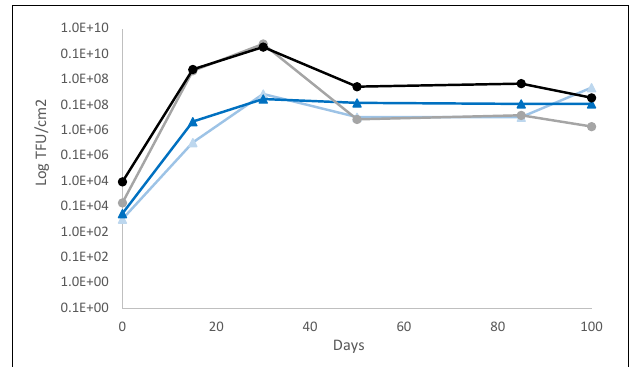
FIGURE 4 | Evolution of P. nalgiovense and P. nordicum populations during pilot-scale fermented sausage productions using challenge tests. P. nalgiovense growth on collagen (gray circles and line) and natural chaudin (black circles and line) casings and P. nordicum growth on collagen (light blue circles and line) and natural chaudin (dark blue circles and line)